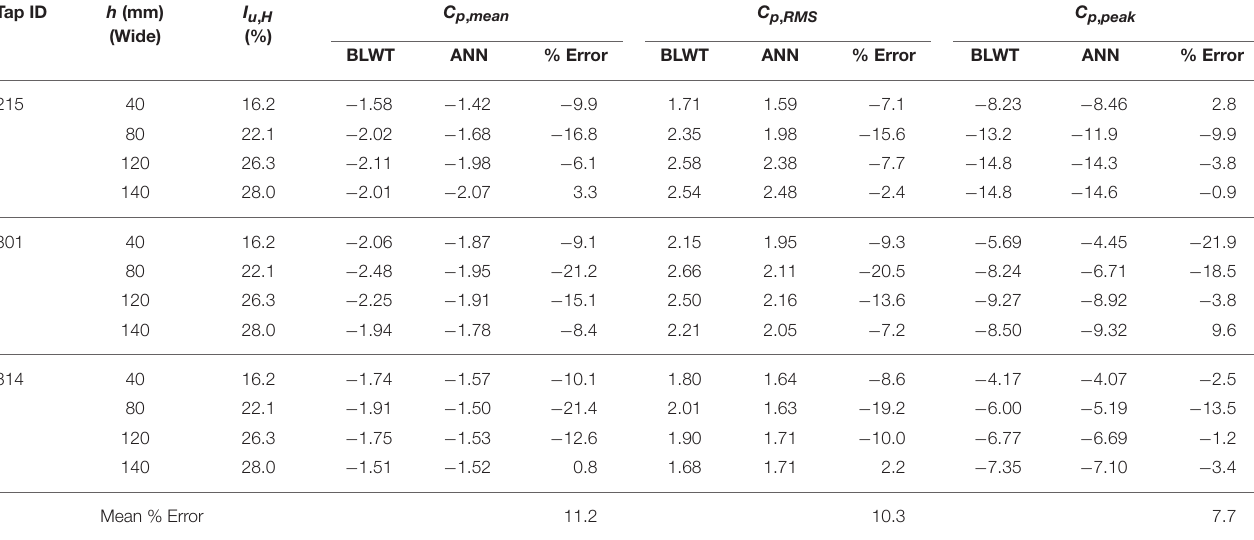
TABLE 6 | Prediction of mean, RMS, and peak pressures for taps 215, 301, and 314 on the 1:20 building